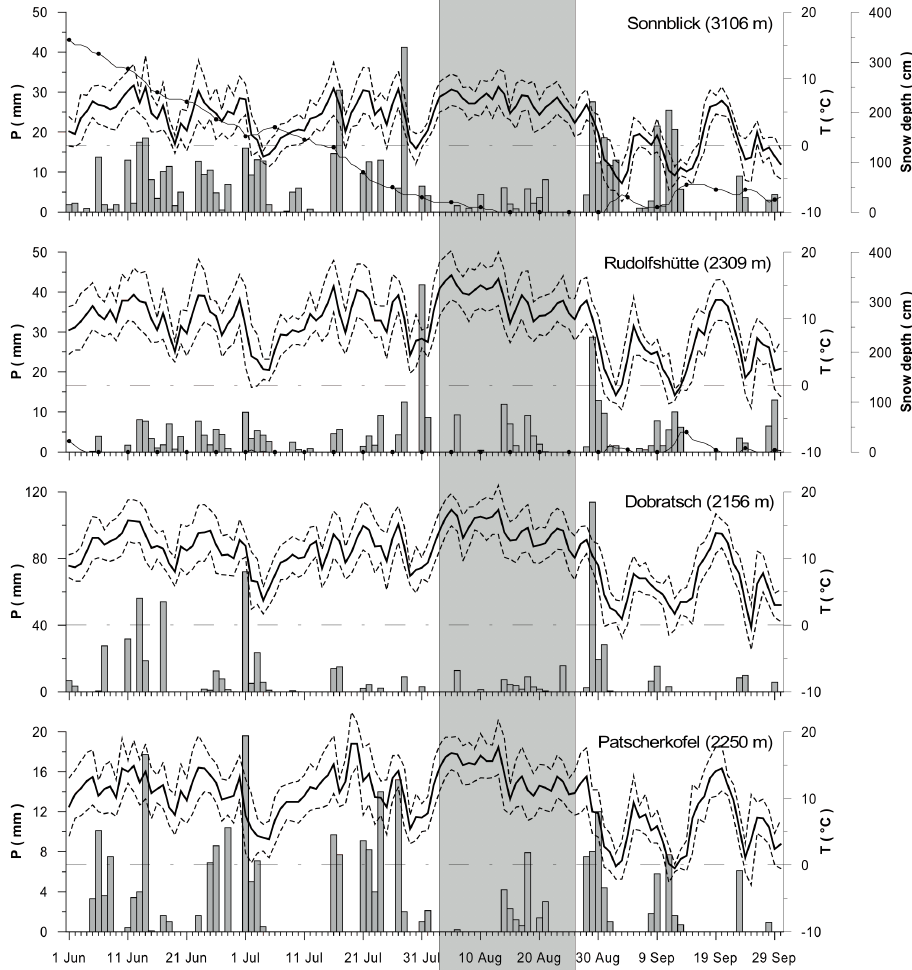
Figure 2: Meteorological observations from four elevated stations in Austria (the location can be seen in Fig. 3) from June 1 st to September 30 th 2003. The dark black line is the daily mean air temperature and the grey dashed lines are the corresponding daily minimum and maximum air temperatures. Grey bars are the daily precipitation amounts and the black dotted lines at the two uppermost diagrams are the observed snow depths. The grey zone indicates the investigated time span from August 3 rd to 27 th 2003.